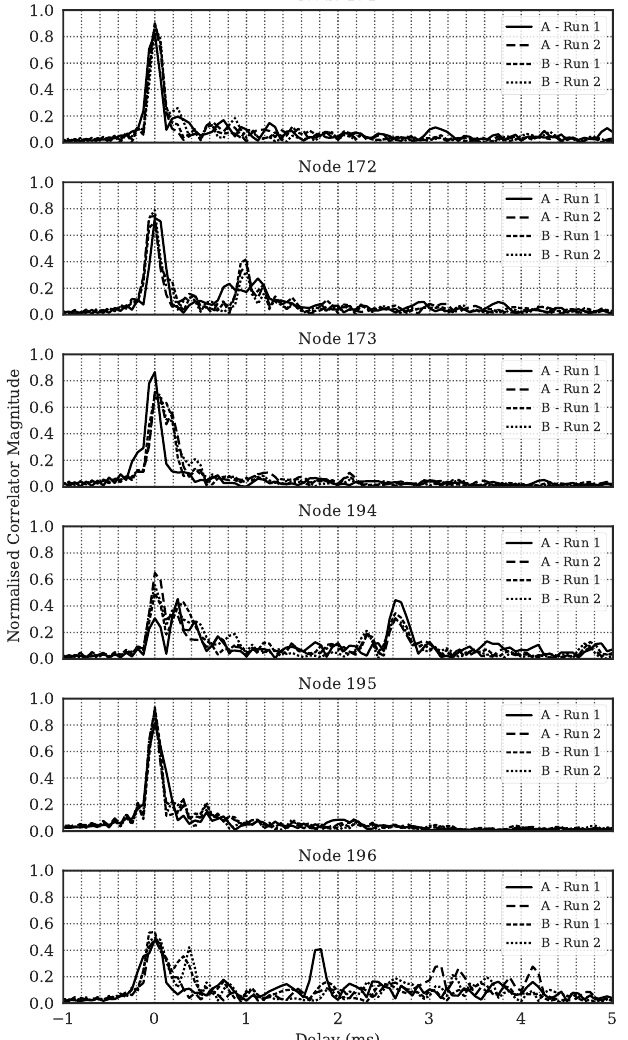
Figure 25. Loch Earn channel impulse response of packets as observed at the shore near 192. A packet for each run is